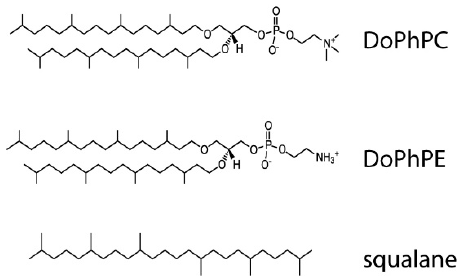
Figure 1. Skeletal formula of the archaeal lipids 1,2-di- O -phytanyl-sn-glycero-3-phosphocholine (DoPhPC), 1,2-di- O -phytanyl-sn-glycero-3-phosphoethanolamine (DoPhPE) and 2,6,10,15,19,23- Hexamethyl-tetracosane (squalane).